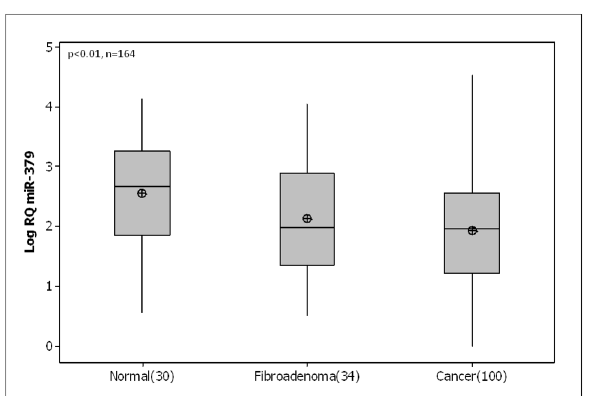
Figure 1. MicroRNA-379 (miR-379) expression in normal, fibroadenoma and malignant breast tissues. RQ-PCR of miR-379 revealed significantly decreased levels of expression in breast cancer n=100 (Mean(SEM) 1.9 (0.09) Log Quantity) compared to normal tissue n=30 (2.6 (0.16) Log RQ, p<0.01).